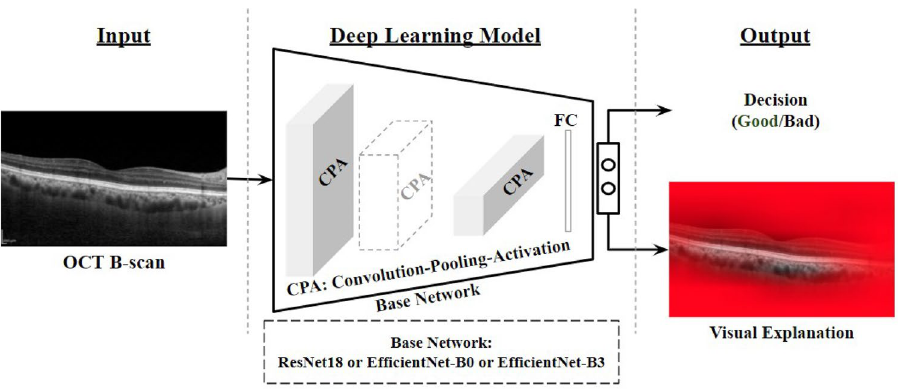
Figure 5. Schematic of the proposed pipeline for assessing quality of an OCT